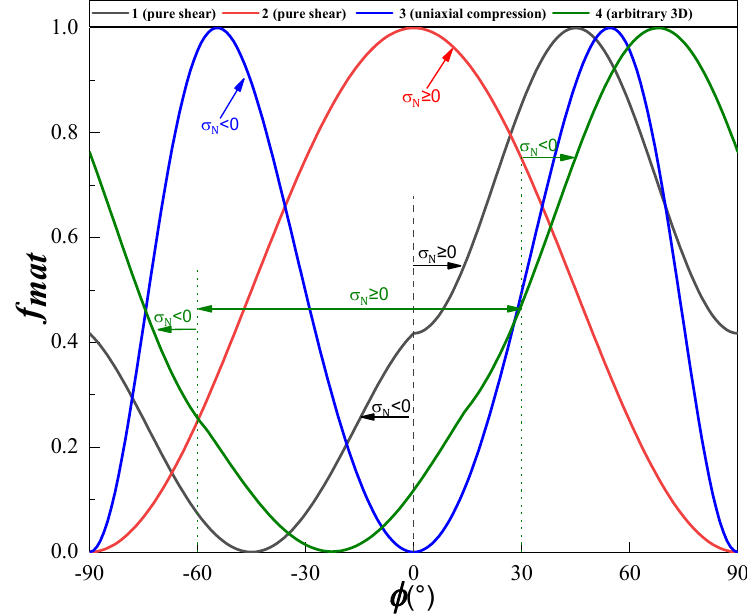
Figure 7. Threshold of matrix damage onset versus ϕ for four typical stress states.